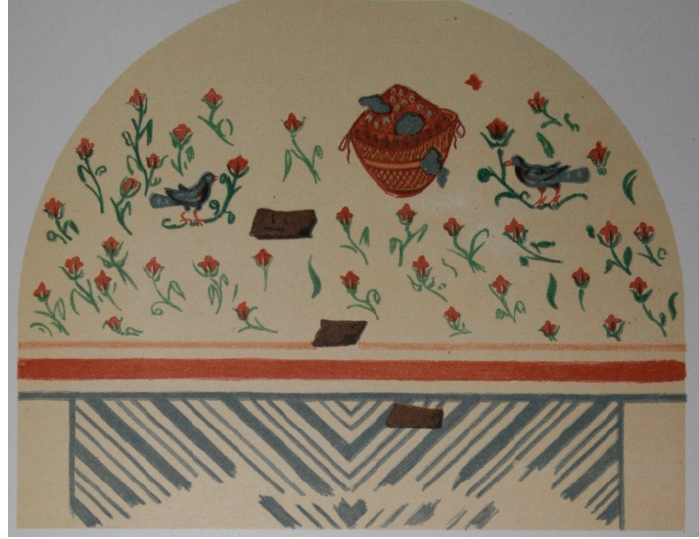
Figure 9. Sardis, “Painted Tomb” (Appendix A.2 T2), painting of south wall. © Archaeological Exploration of Sardis/President and fellows of Harvard College.